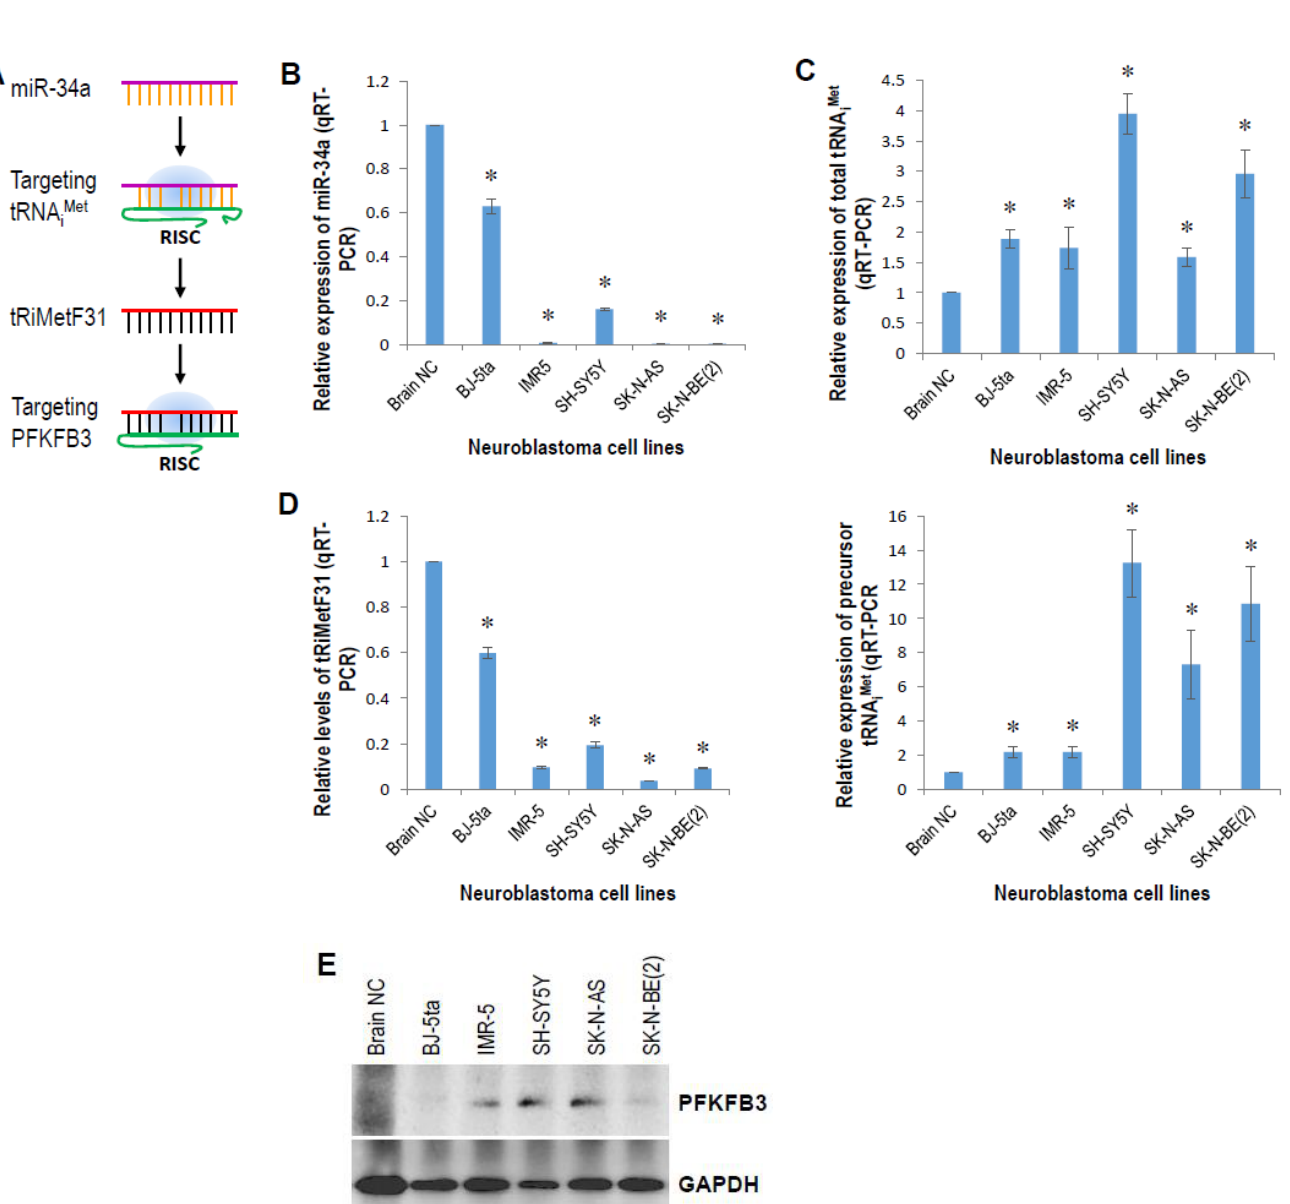
Figure 3. Inverse correlation between tRiMetF31 and its target PFKFB3. ( A ) Diagram of tRiMetF31 targeting PFKFB3. ( B – D ) Total RNA was isolated from BJ-5ta, IMR-5, SH-SY5Y, SK-N-AS, and SK-N-EB(2) cell lines and normal brain tissue, and subjected to qRT-PCR analysis of miR-34a, tRiMetF31, total tRNA iMet and tRNA iMet precursor as detailed in Section 4. ( E ) Whole cellular lysates were prepared from BJ-5ta, IMR-5, SH-SY5Y, SK-N-AS and SK-N-EB(2) cell lines and normal brain tissue and subjected to Western blotting with antibody to PFKFB3, GAPDH served as a loading control. *, p < 0.05. Original western blot data is shown in Figure S3.